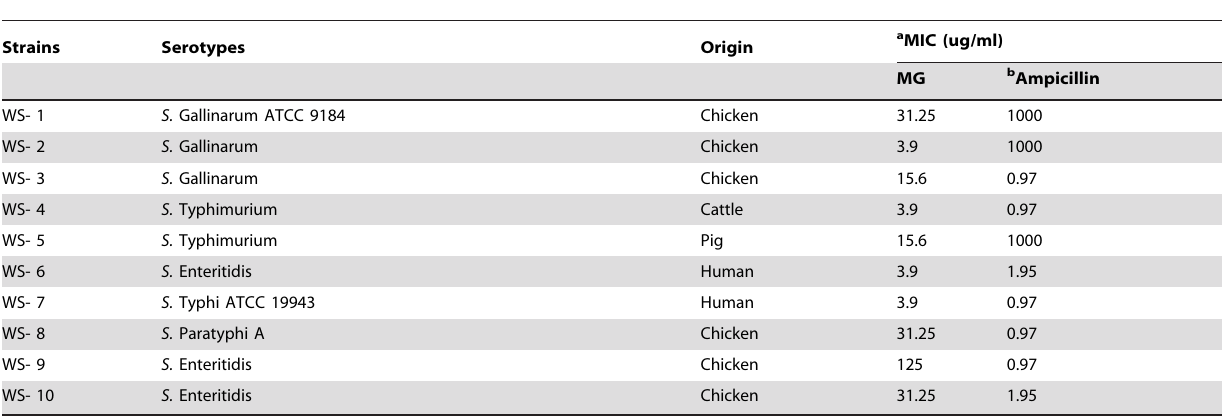
Table 3. Antimicrobial activity of MG and ampicillin against 10 strains of Salmonella .